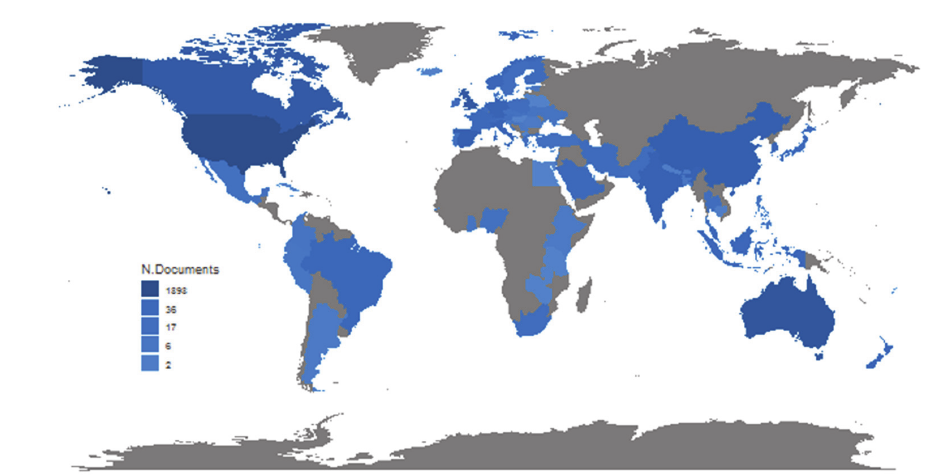
Fig. 1. Country Scientific